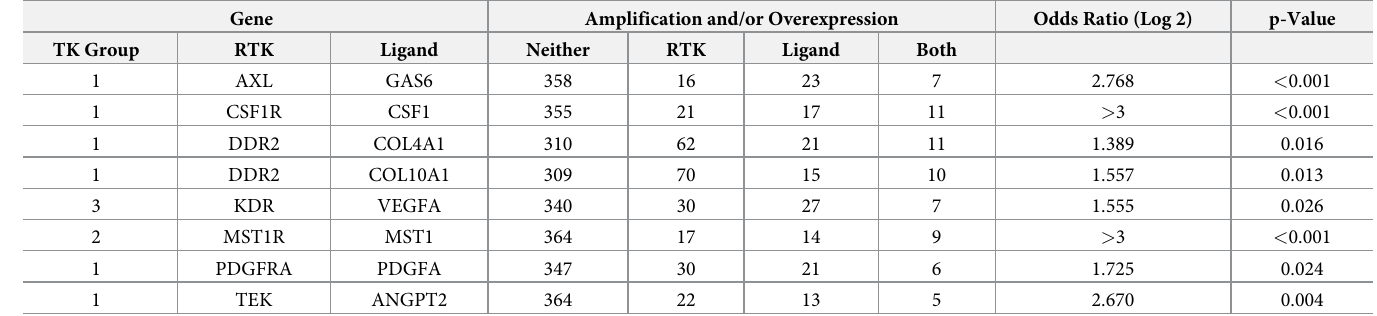
Table 2. Significant co-occurrence of potentially oncogenic alterations (RNASeq V2 > 2-fold and/or gene amplification) for RTKs and cognate ligands in BCa TCGA dataset analyzed by Robertson et al. (n = 408) [22] and differences in median OS and